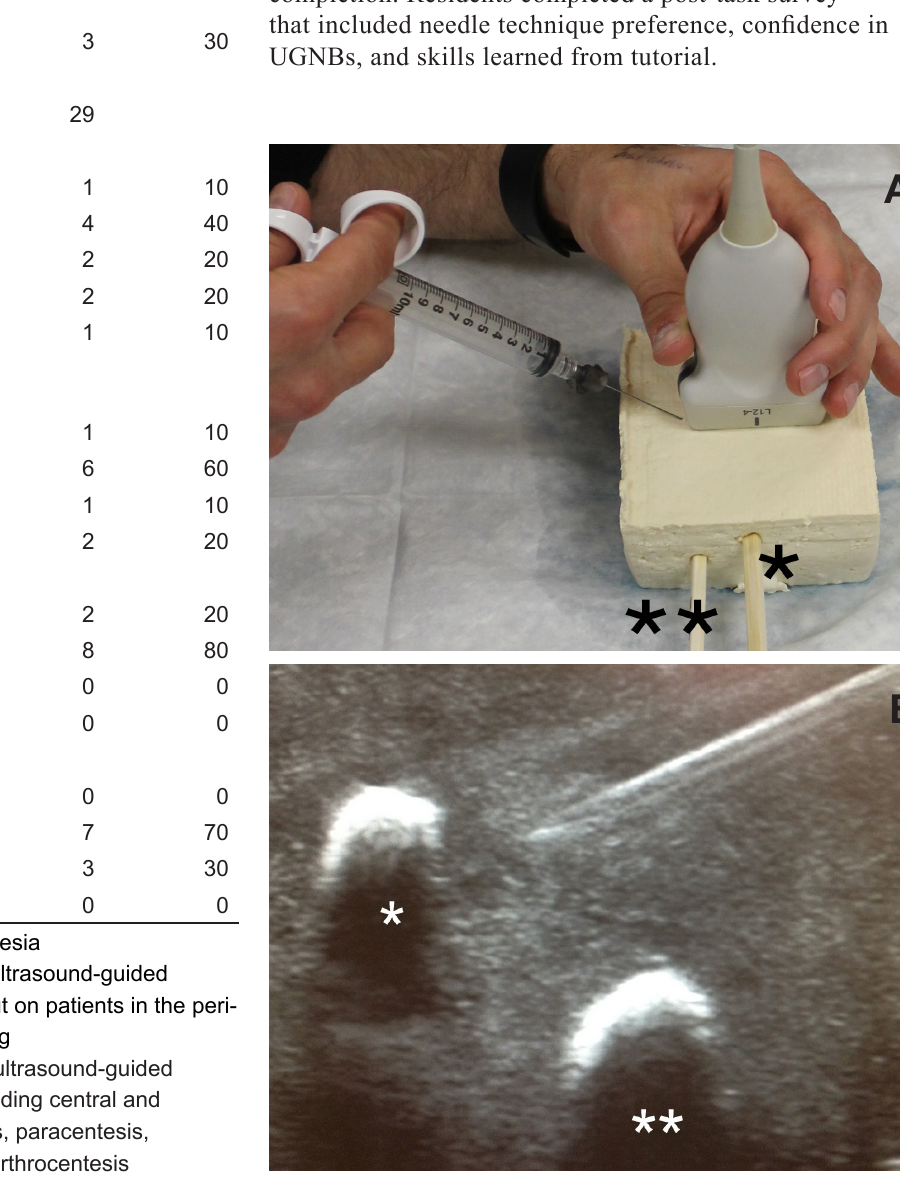
Figure 2. A, Simple phantom model made of extra-firm tofu (10 by 8 by 4cm) with two wooden dowels inserted in parallel fashion to simulate nerve (*) and adjacent vessel (**). B, Ultrasound image of simple model with modeled nerve (*) and vessel (**) with inplane needle view using a linear 12-5MHz transducer with appropriate gain and depth set by one of the study